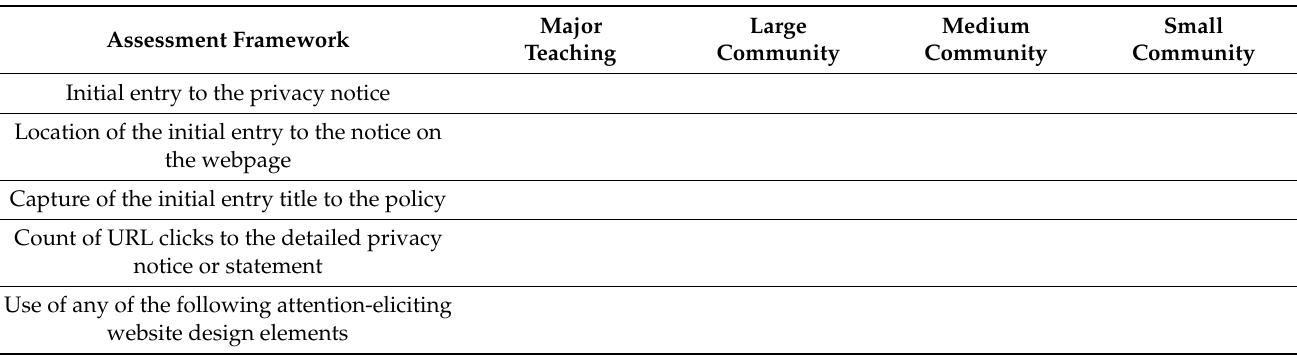
Figure 1. URL to Privacy Policy from main webpage. Table 1. Criteria comparison matrix example.